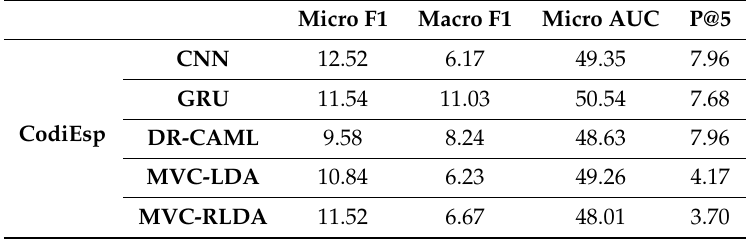
Table 7. Results of flat models on top 50 codes obtained on the CodiEsp